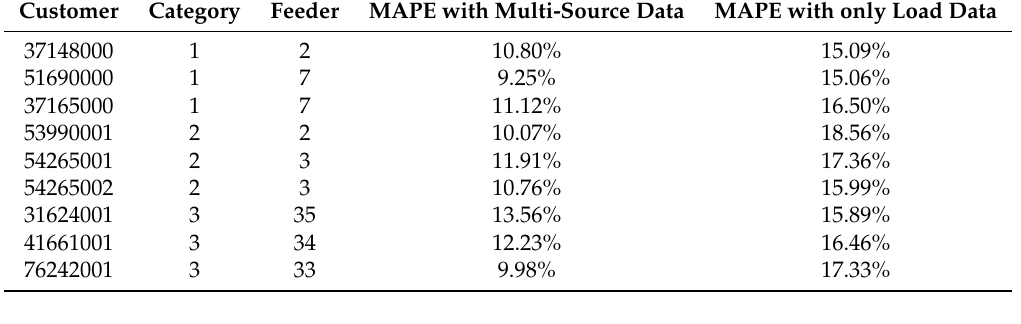
Table 8. Compared MAPEs for nine customers in three categories with multi-source data or only load data.